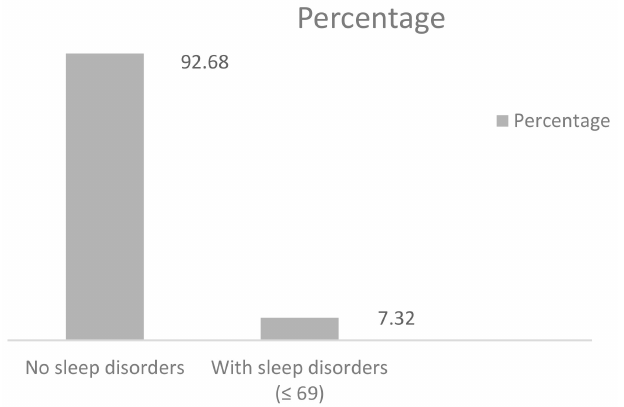
Figure 2. Sleep disorder profile by SDSC (%).